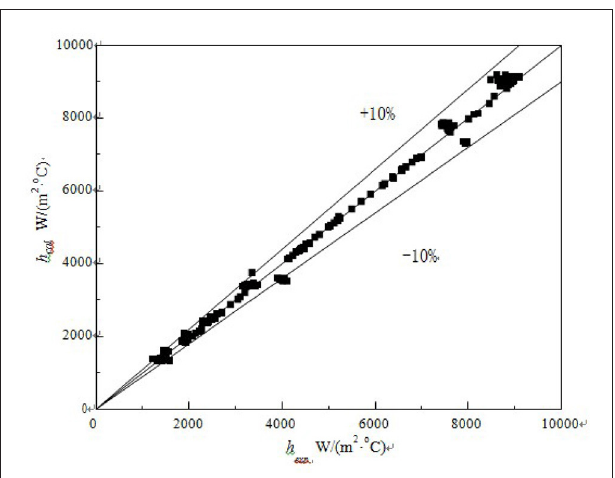
FIGURE 7 | Comparison of the predictions by correlation with experimental